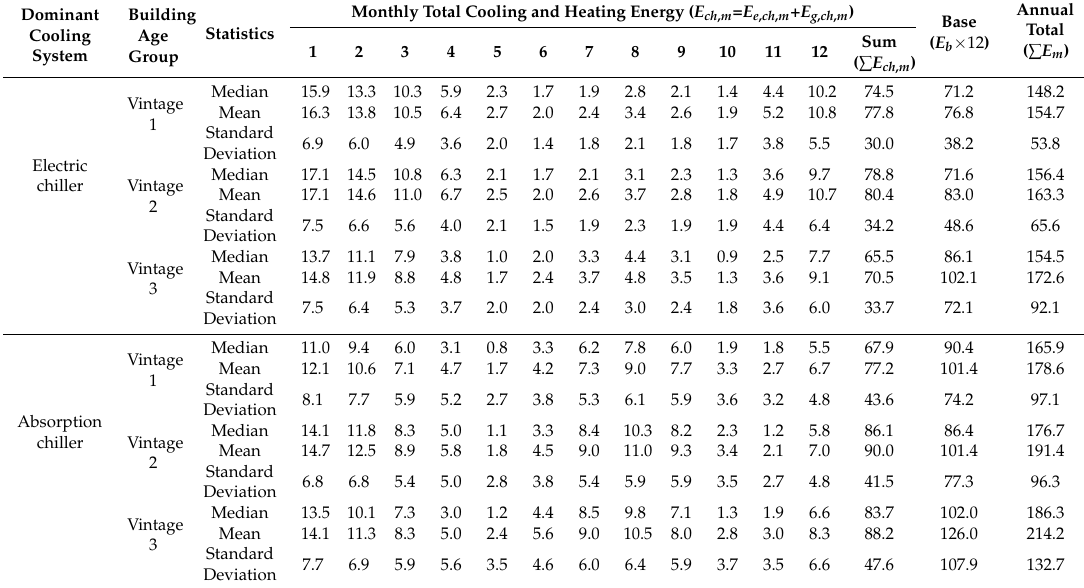
( c ) Monthly total energy ( 𝐸 (cid:3040) ) Figure 9. Boxplots showing the monthly ( a ) electric energy consumption ( E e , ch , m ), ( b ) gas energy consumption ( E g , ch , m ), and ( c ) total energy consumption ( E m ) of buildings predominantly cooled using absorption chillers (n = 1527). (Boxplot in MATLAB R2018b was used). Table 3. Statistical data of cooling/heating energy and base energy (unit: kWh/m 2 ).